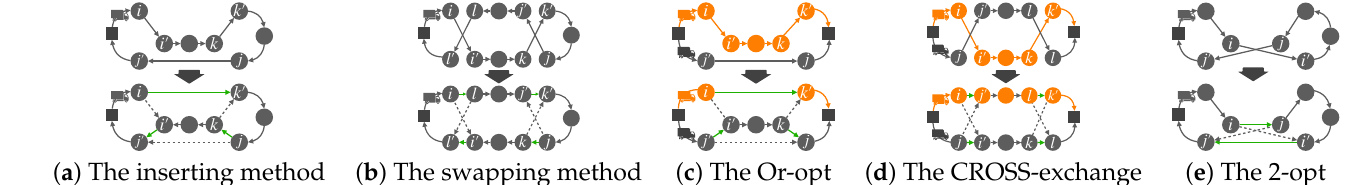
Figure 5. Five local search methods ( a – e ) used in this study. Black rectangles represent depots and gray and orange circles indicate ports. Letters in the circles indicate the port number. In these figures, dotted lines represent edges removed by the local search method, and green lines represent newly added